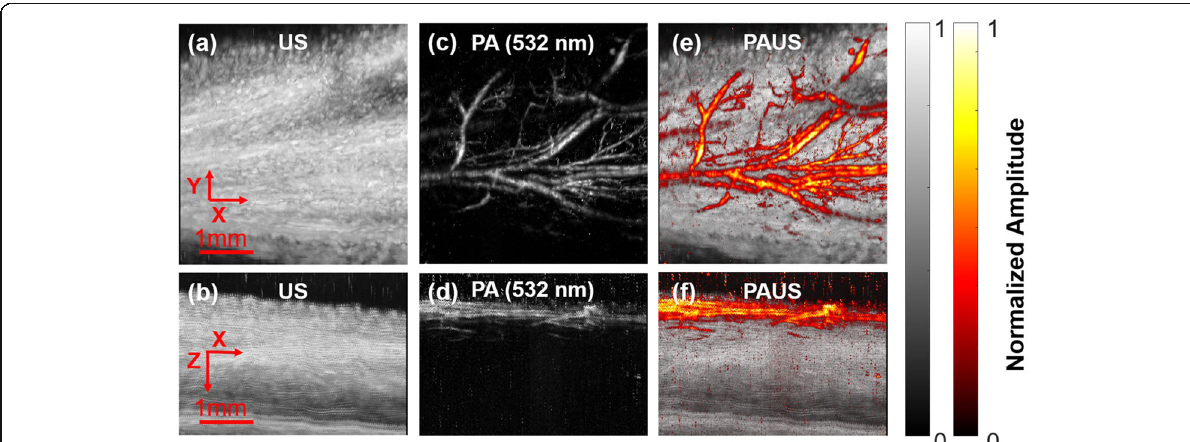
Fig. 3 Concurrent PAUS of a mouse hind paw. In vivo PAUS results of a mouse ’ s hind paw, showing the XY and XZ projections for US ( a , b ), PA ( c , d ), and fused PAUS ( e , f ). The FOV in the XY plane is 4.8 × 4 mm